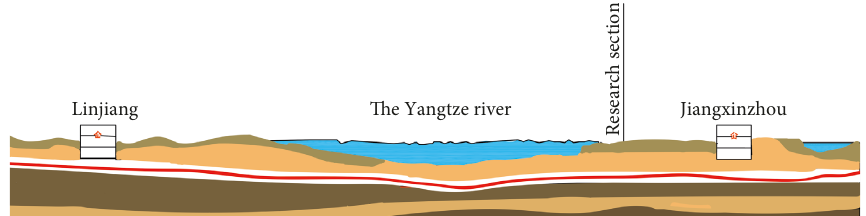
Figure 2: Research section of Nanjing Metro Line 10.